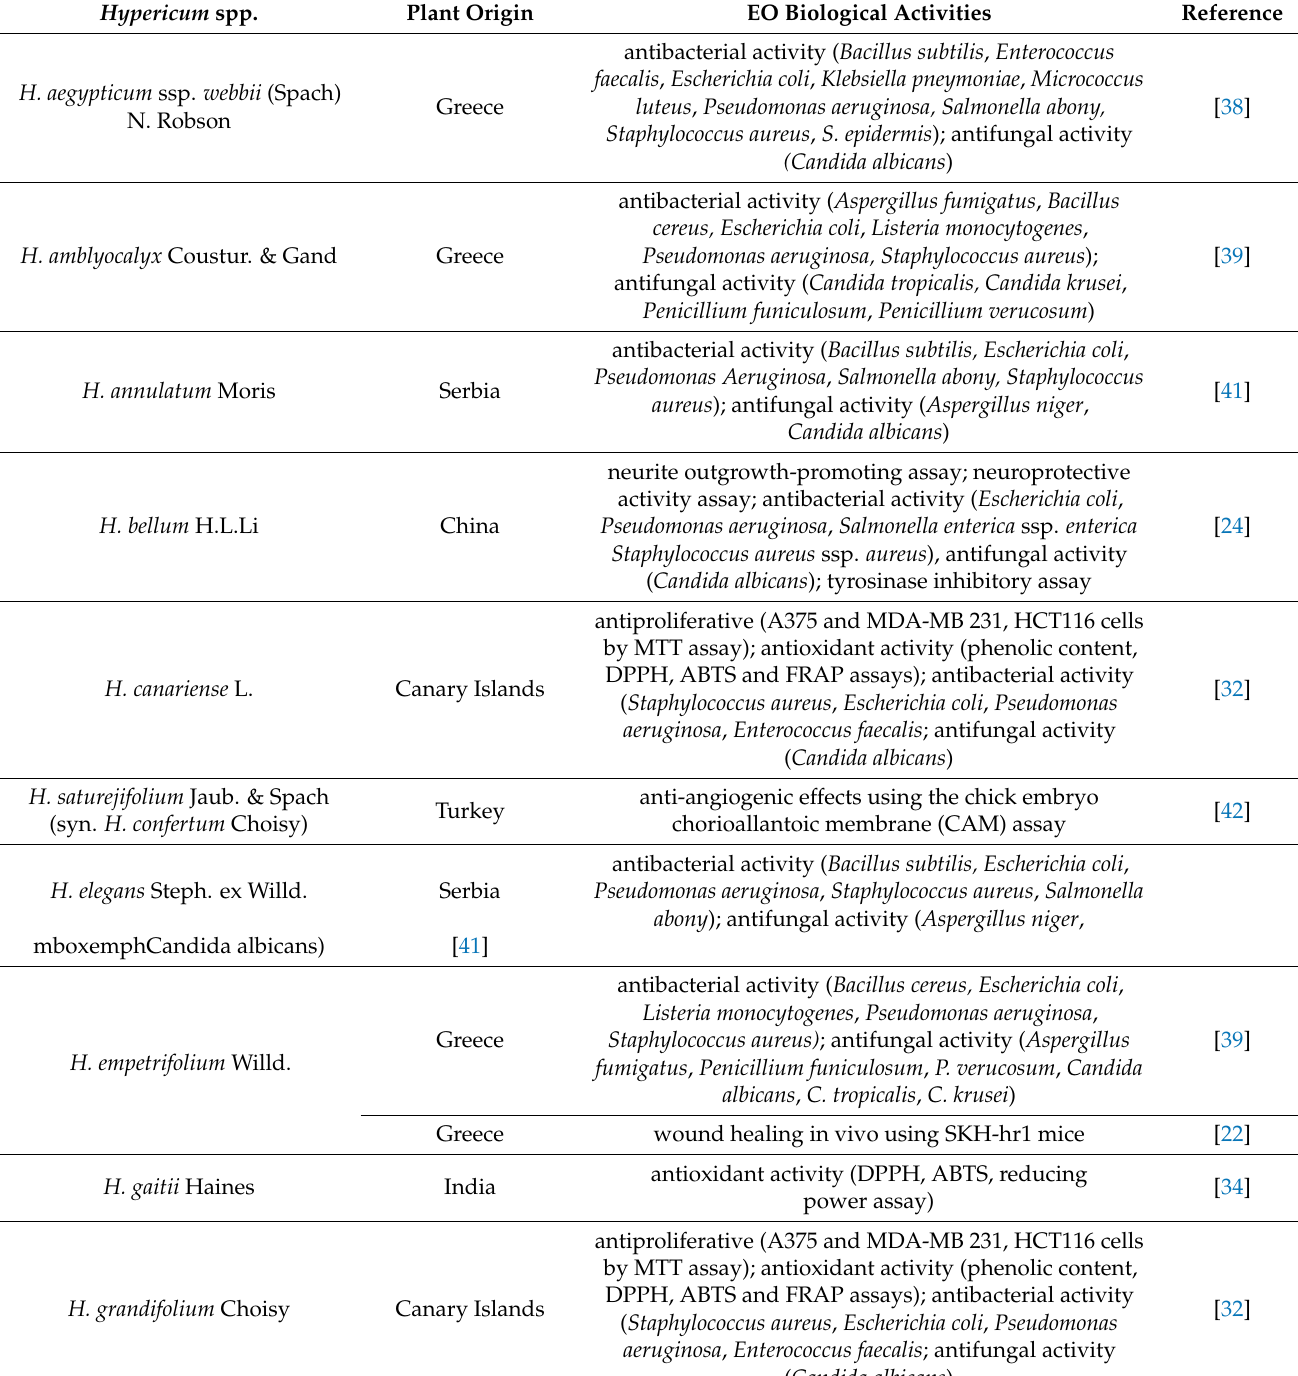
Table 2. Survey of the biological effects exerted from Hypericum spp. EOs. Hypericum